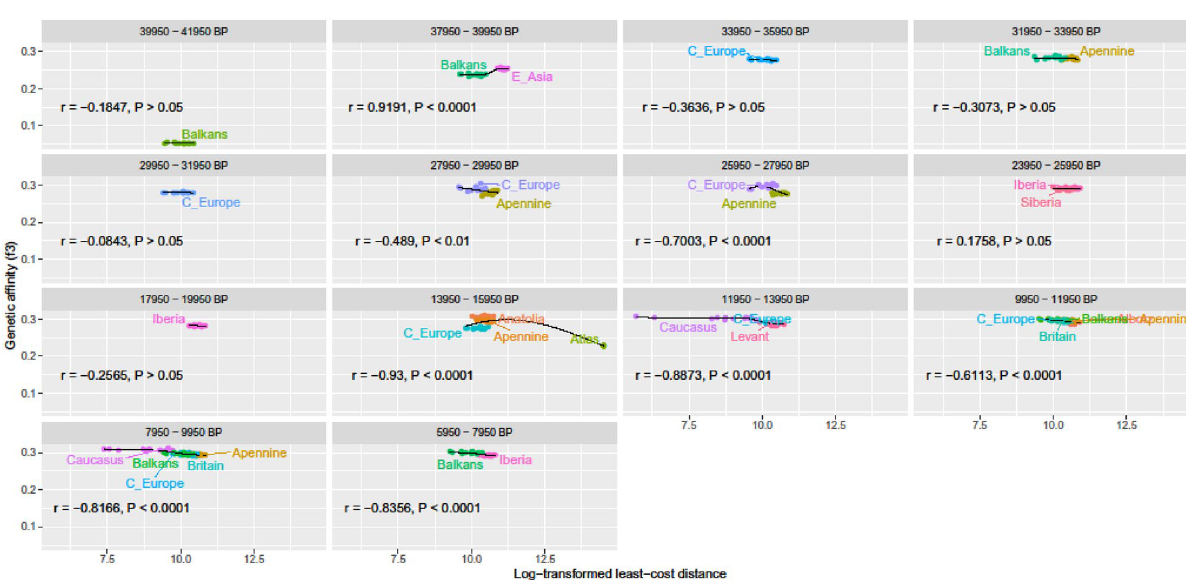
Figure 2. Genetic affinity (f3) between modern Caucasians and ancient populations.